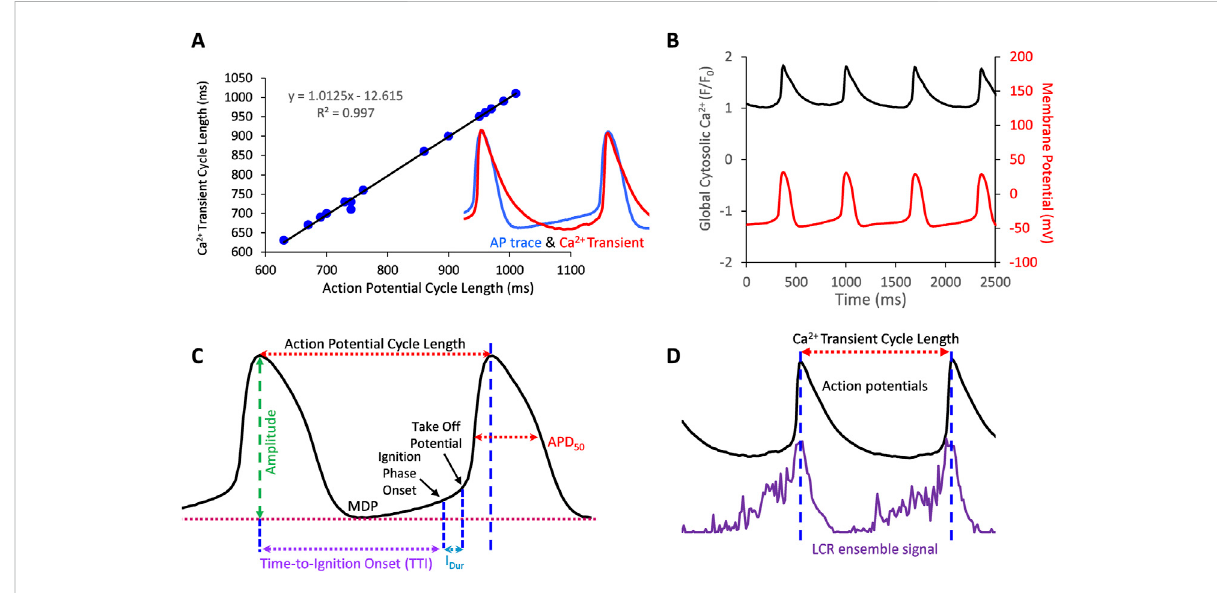
FIGURE 1 (A) Action potentials and AP-Induced Ca 2+ transients are highly correlated in SANC in which both Ca 2+ and V m were simultaneously measured (17cyclesmeasuredsimultaneously). (B) ,exampleofasimultaneousV m andCa 2+ recording. (C,D) IllustrateV m andCa 2+ parametersmeasuredinthis